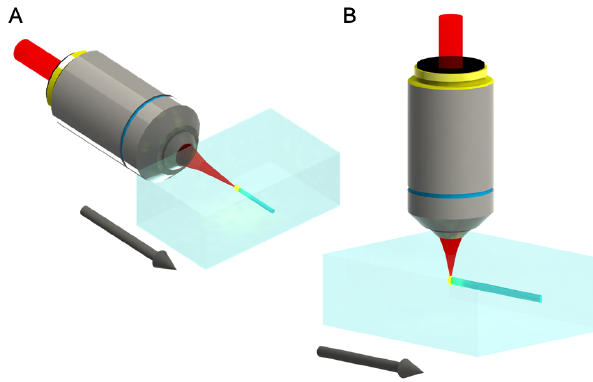
Figure 1: Longitudinal (A) and transverse (B) ultrafast laser inscrip- tion. The arrow indicates the sample’s translation direction.